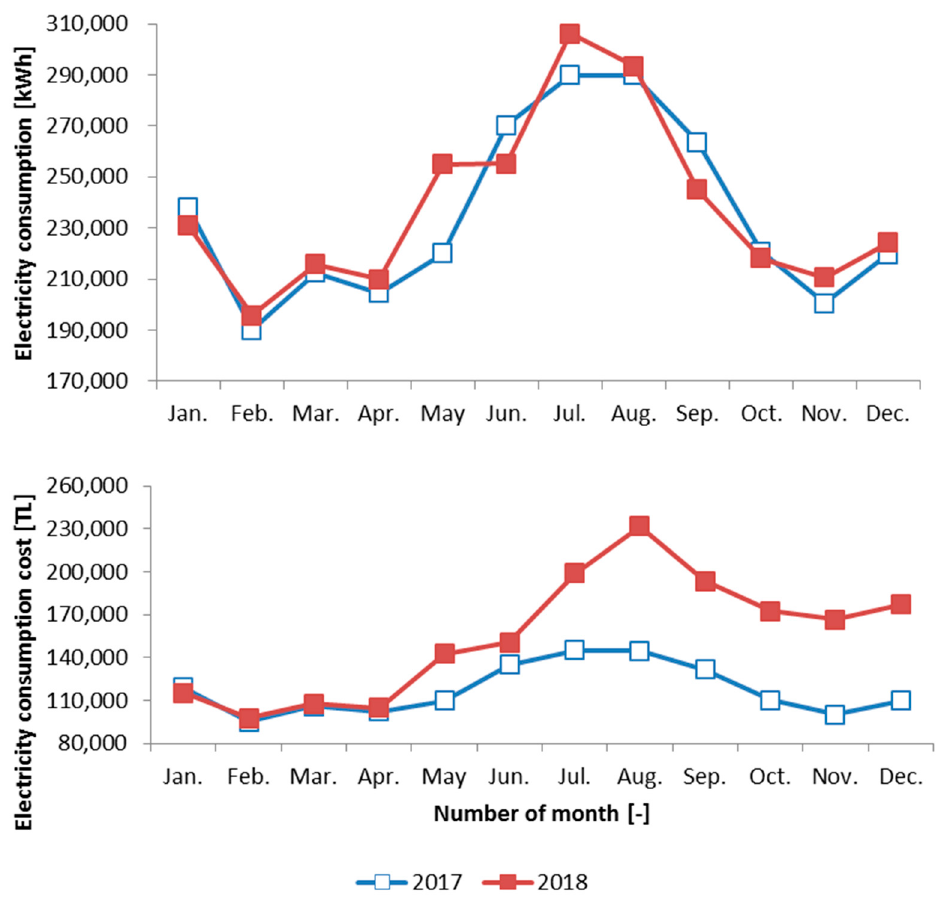
Figure 3. Monthly electricity consumption and costs during the period of 2017–2018.